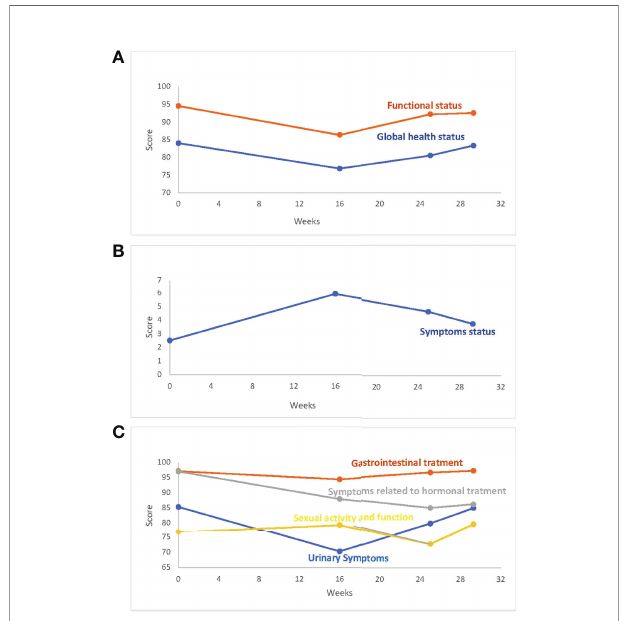
FIGURE 3 | PRO (A) . QLQ30_Global Health Status/Functional Status. (B) QLQ30_Symptoms Status. (C) QLQ_PR25. PROs score is displayed in the Y- axis. Weeks after pretreatment assessment are displayed in the